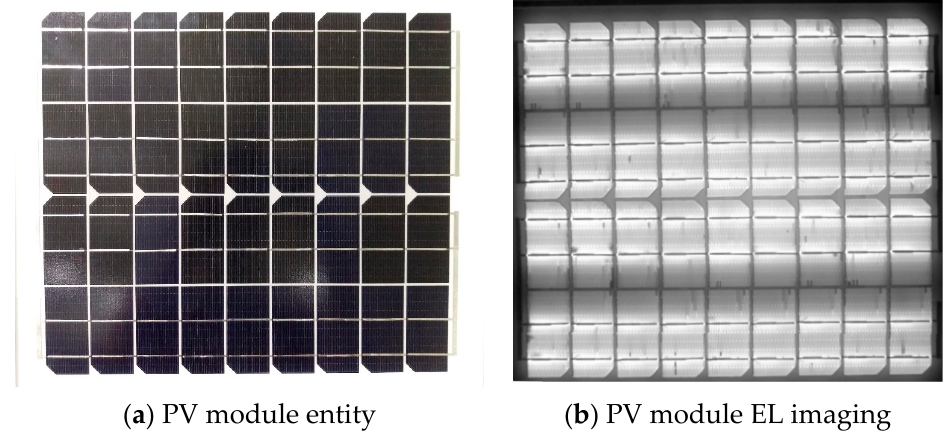
Figure 5. Built-in normal PV module.